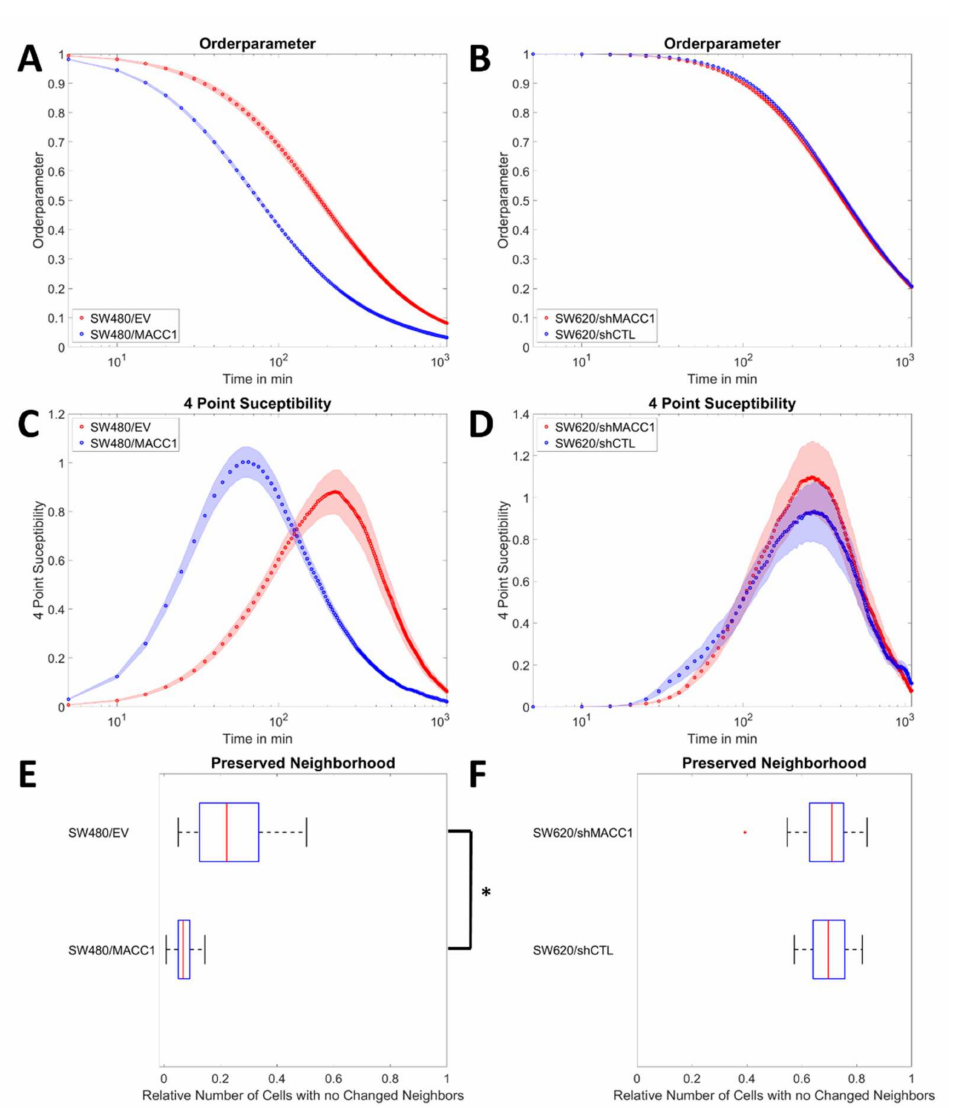
Figure 3. Collective migration properties of SW420 and SW620 cells. ( A , B ) Order parameter Q for both cell lines for the 20 h time window. ( C , D ) Four-point susceptibility as obtained from the velocity fields over the whole measurement time. The peak positions of the 4-point susceptibility represent the average life time of collectively moving packs of cells. ( E , F ) Analysis of the layer reorganization in terms of cells that did not make new neighbors during live-cell imaging. Sample sizes: n SW480/EV = 75; n SW480/MACC1 = 75; n SW620/shMACC1 = 32; n SW620/shCTL = 32. Shaded areas depict the standard error of the mean. Box plots show the median (red line), 25 and 75 percentile (box), non-outlier range (whiskers), and outliers (red dots). Asterisk depicts statistically significant results with p <